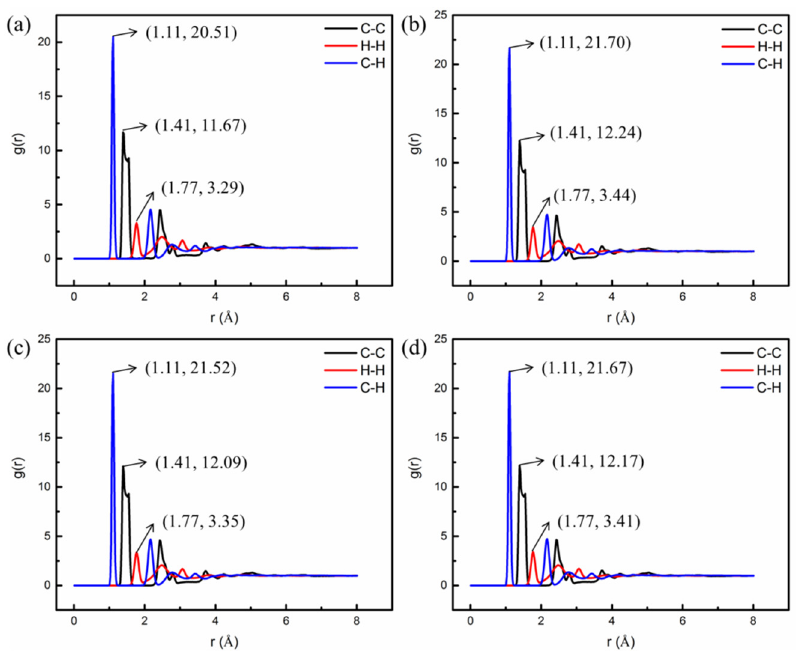
Figure 15. RDF of atoms in four modified asphalt systems: ( a ) SBS modified asphalt; ( b ) 5 Å OvPOSS/SBS modified asphalt; ( c ) 7 Å OvPOSS/SBS modified asphalt; ( d ) 9 Å OvPOSS/SBS modified asphalt.